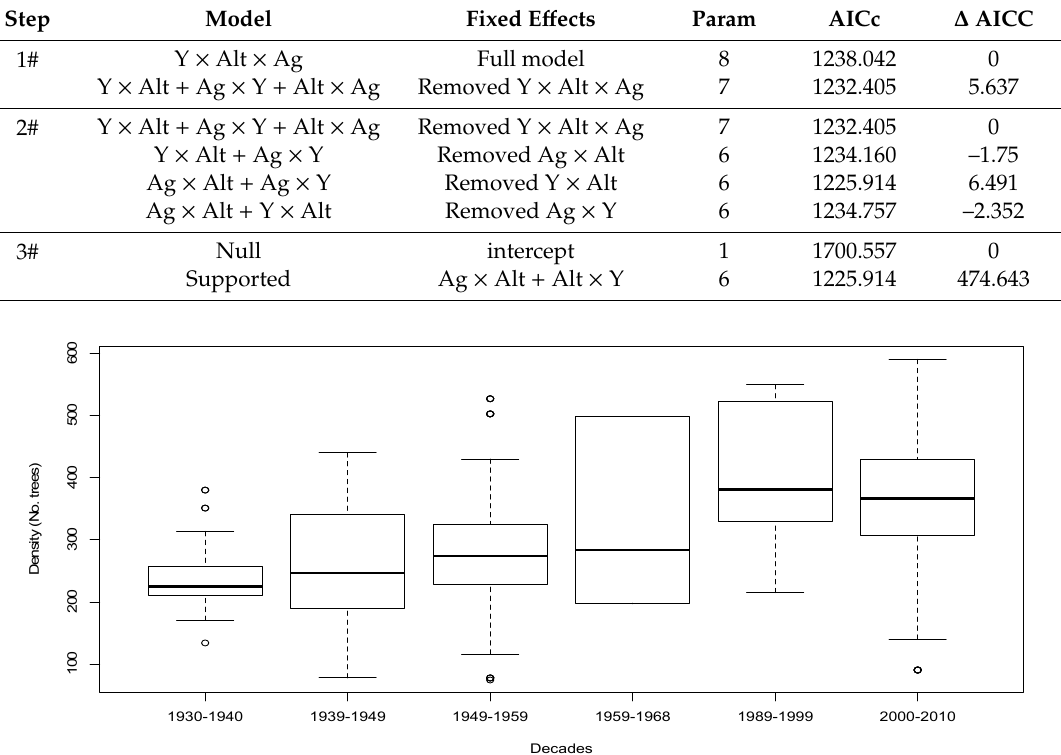
Figure 2. Tree density (in the 45 units) increase in the last decades in Navafría, Sierra the Guadarrama, Spain.